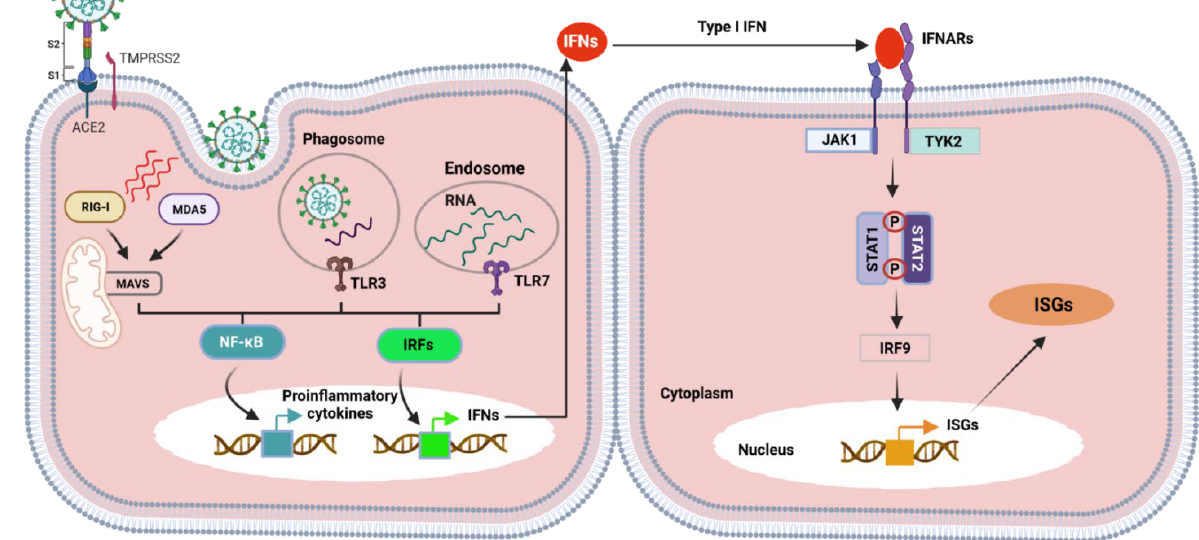
Figure 3. Schematic representation of the cellular innate responses against SARS-CoV-2 virus. Following the recognition of the viral PAMPs by PRRs, the downstream signaling molecules are activated. The PRR on the epithelial host cell are transmembrane localized Toll-like receptors (TLRs) and the cytosolic RIG-I-like receptors, which include the helicases: RIG-I (retinoic acid-inducible gene I), and MDA-5 (melanoma differentiation-associated gene 5). The PAMP ligand for RIG-I-like receptors is specific viral ssRNA structures with 5 (cid:48) -triphosphate termini (5 (cid:48) ppp) or long dsRNA. The TLR-3 and TLR-7 signaling pathways are subsequently activators for the IFN regulatory factors (IRFs) and the nuclear factor kappa-light-chain-enhancer of activated B cells (NF–kB), leading to proinflammatory cytokine and type-I IFN production. Following their expression, type-I IFNs induce a variety of signal transduction pathways by targeting different signaling receptors on the neighboring cell. Secreted IFN binds to a heterodimeric transmembrane receptor, composed of the subunits IFNAR1/2, to catalyze the dimerization of the IFNAR1 and IFNRA2 chains of the receptor. This dimerization stimulates the autophosphorylation of the receptor-associated tyrosine-protein kinase 1 (JAK1) and tyrosine kinase 2 (Tyk2). Subsequently, the JAK1/Tyk2 phosphorylates the downstream substrates STAT1 and STAT2. To form the essential heterotrimeric transcriptional factor complex IFN-stimulated gene factor 3 (ISGF3), active/phosphorylated STAT1 and STAT2 engage the IFN regulatory factor IRF9 in the cytoplasm. Furthermore, the ISGF3 complex localizes in the nucleus to bind the cis-element of the IFN-stimulated response element (ISRE) and stimulate the transcription of plenty of antiviral ISGs. Figure has been created using